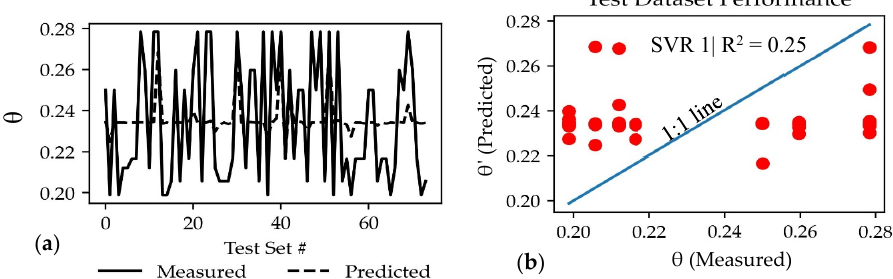
Figure 13. SVR1 soil moisture content evaluation metrics: measured ( θ ) vs. predicted ( θ ’) for the test samples. ( a ) Line plot. ( b ) Scatter plot.